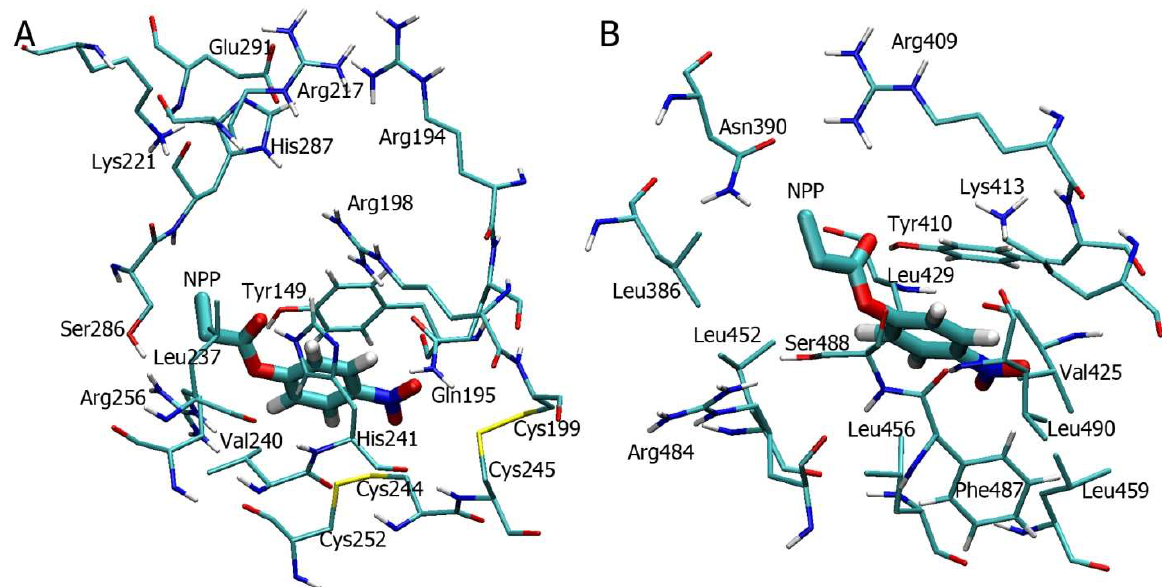
Figure 11. Result of molecular docking of NPP into the ligand-binding sites of BSA. ( A ) Sudlow site I with catalytic tyrosine Tyr149; ( B ) Sudlow site II with catalytic Tyr410.